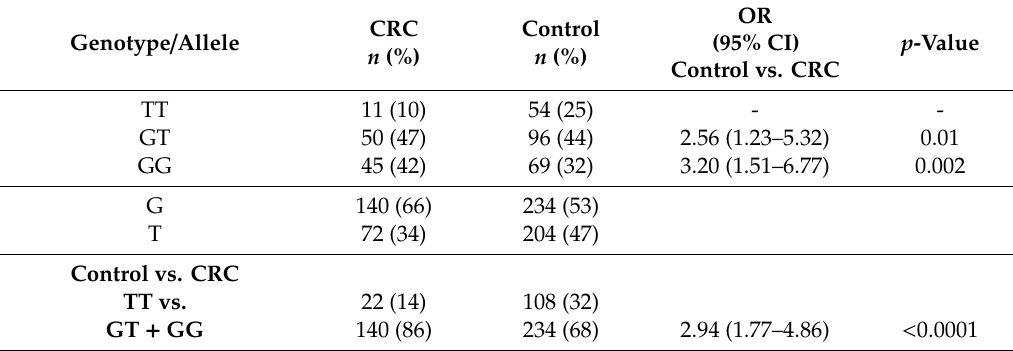
Table 2. Genotype and allele frequencies of CYP27B1 single nucleotide polymorphism (SNP) rs10877012 polymorphism in CRC and control